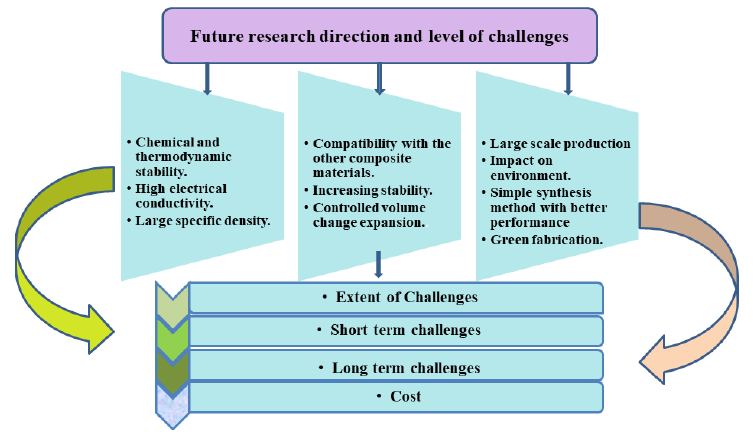
Figure 11. Future research direction and level of challenges.